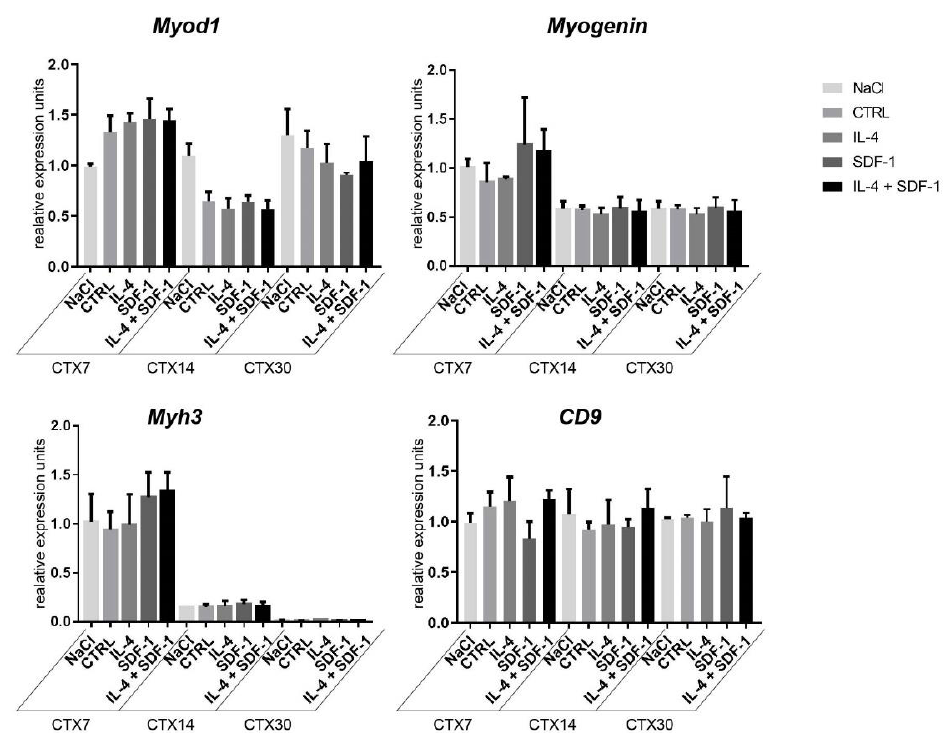
Figure 5. Expression of mRNA encoding myogenic factors in mouse skeletal muscles transplanted with mADSCs pretreated with either IL-4, SDF-1, or IL-4 and SDF-1. Analysis of the level of mRNAs encoding MYOD, MYOGENIN, MYH3, and CD9. Expression was related to the mean expression level in control muscle analyzed at day 7 and normalized to mRNA encoding HPRT. CTX7 - day 7; CTX14 - day 14; CTX30 - day 30 of regeneration, for each experimental group n ≥ 3. Data are presented as mean ± SD. Data have been analyzed using Kruskal-Wallis